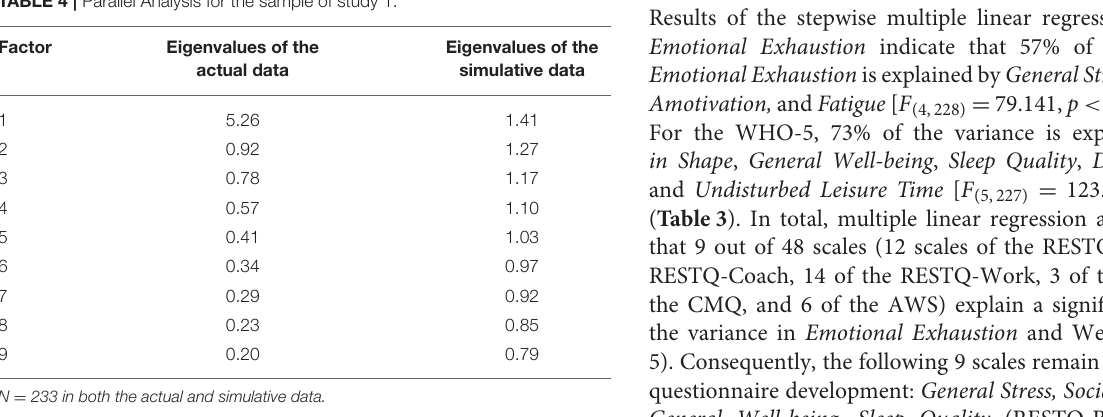
TABLE 4 | Parallel Analysis for the sample of study 1.